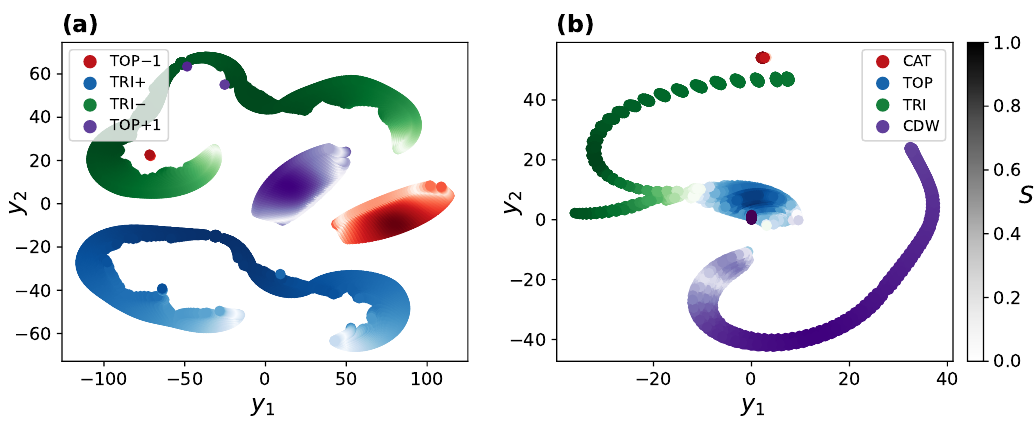
Figure 7: Clustering with t-SNE . The plot shows the visualization of the data pro- jected in 2D applying t-SNE (components y , y ). In both panels we assign a color to 1 2 each point corresponding to its phase in the model while the brightness of each point corresponds to its silhouette (see Section 3.B). (a) Projection of the non-interacting model data points. Four clusters appear evidently and they correspond to the 3 phases of the non-interacting model with the two trivial phases (TRI + , TRI-) sep- arated. The silhouette of the points (brightness of the color) highlights the points close to a phase transition, which happen to be at the borders of each cluster. (b) Projection of the interacting model data points. The separation of the clusters is less neat compared to (a) but thanks to the silhouette we can see the borders of each